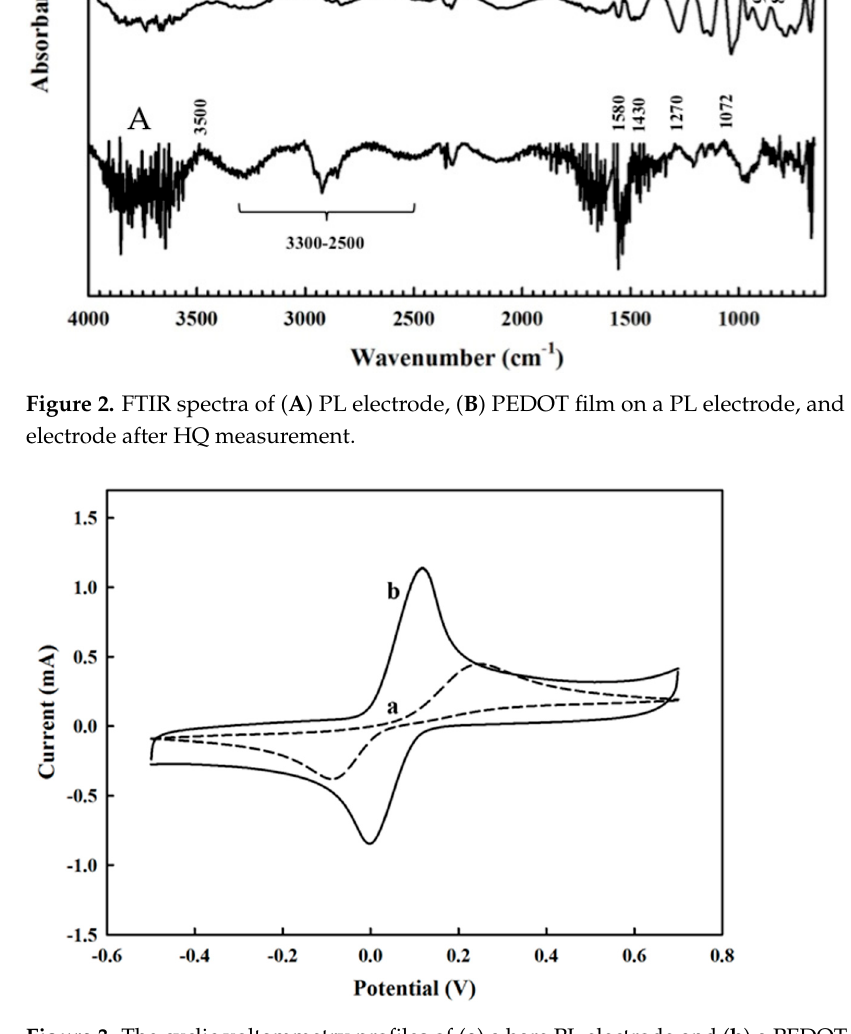
Figure 3. The cyclic voltammetry profiles of (a) a bare PL electrode and (b) a PEDOT/PL electrode in response to 6 mM of hydroquinone in PBS buffer. The potential was swept from − 0.5–0.7 V with the rate of 100 mV s − 1